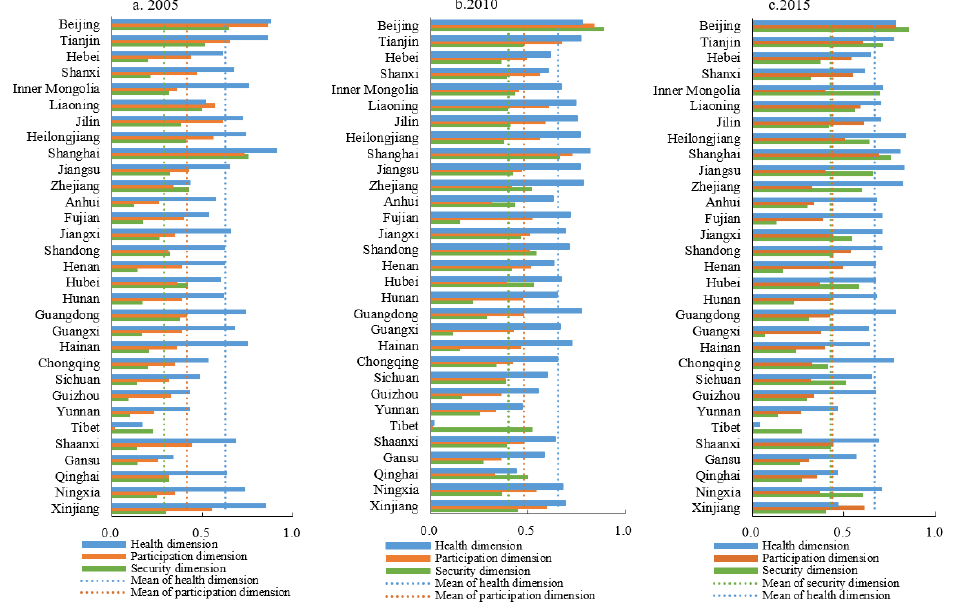
Figure 2. Measurement results of quality of life for the oldest-old in China,